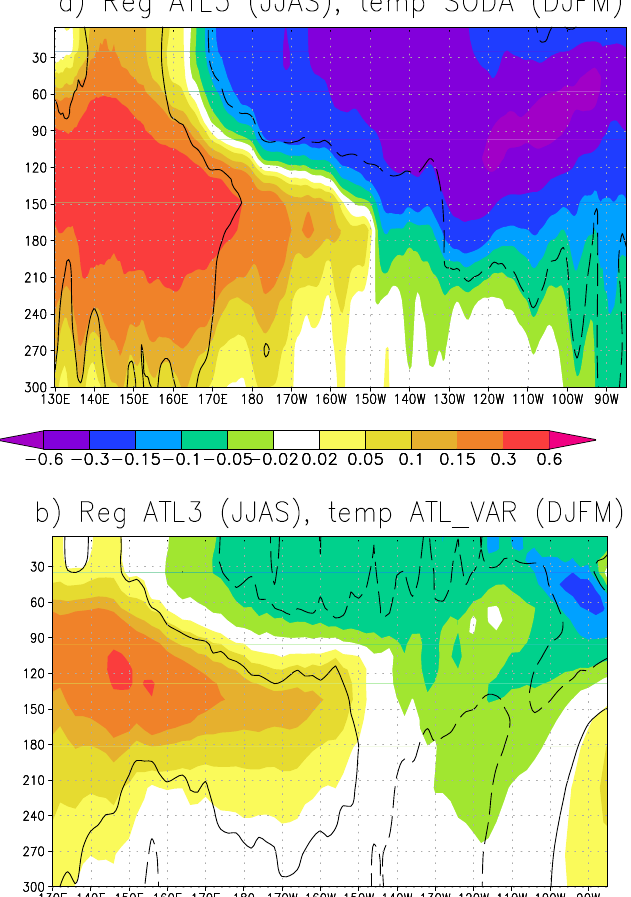
Figure 3. Regression of ( a ) observed; ( b ) ATL_VAR temperature near the equator (DJFM; averaged from 5 ◦ S to 5 ◦ N) onto the preceding (JJAS) ATL3 index. Anomalies that are 95% statistically significant are indicated by contours. Units are